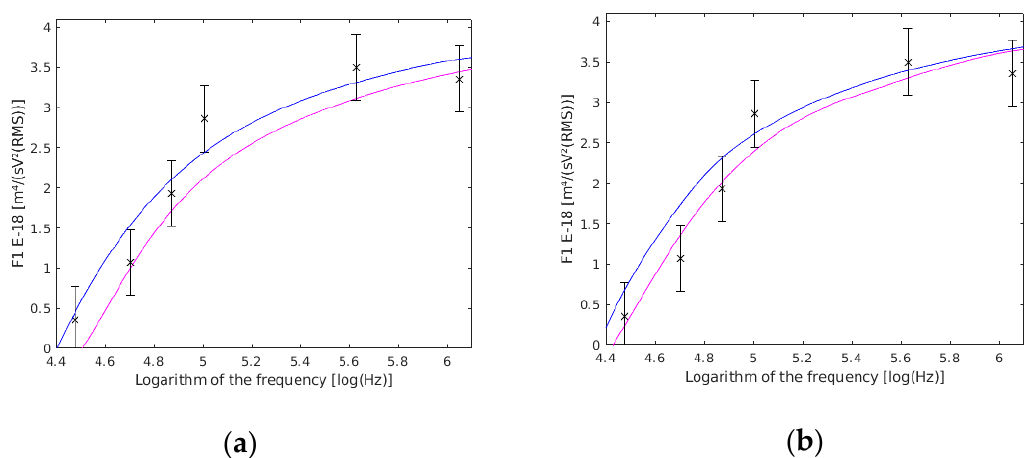
Figure 8. ( a ) F 1 variation with the cell wall thickness (dw). F 1 with a 0.275 µ m cell wall thickness are shown in magenta, those with a 0.225 µ m cell wall thickness are shown in blue, and the results of this work are the six frequency points with their confidence interval drawn. ( b ) F 1 variation with the cell membrane thickness (dm). F 1 with a 0.0077 µ m cell membrane thickness are shown in magenta, those with a 0.0063 µ m cell membrane thickness are shown in blue, and the results of this work are the six frequency points with their confidence intervals